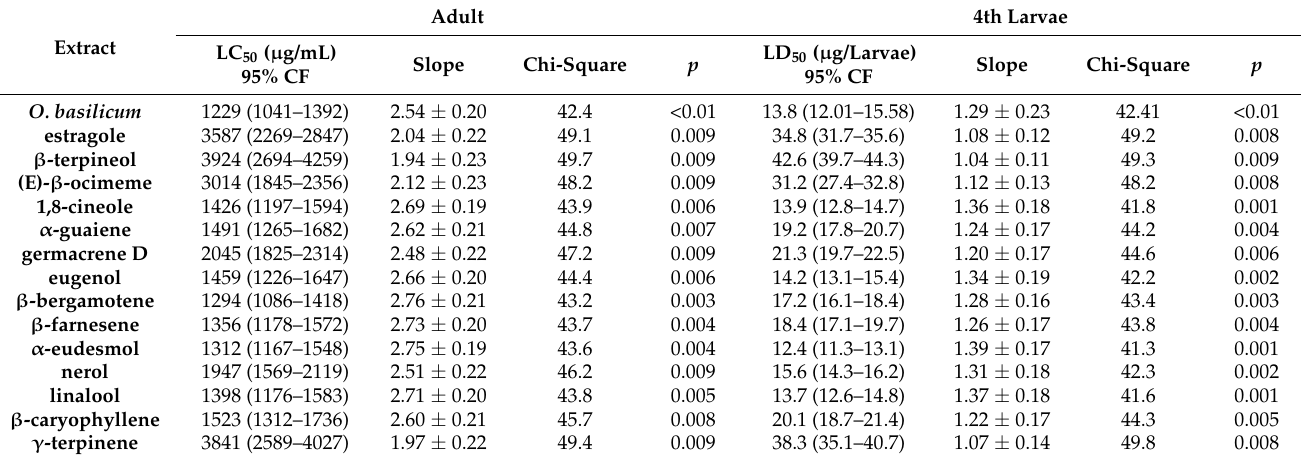
Table 2. Probit and mortality analysis of R. ferrugineus adults and fourth larvae treated with pure compounds and O. basilicum volatile